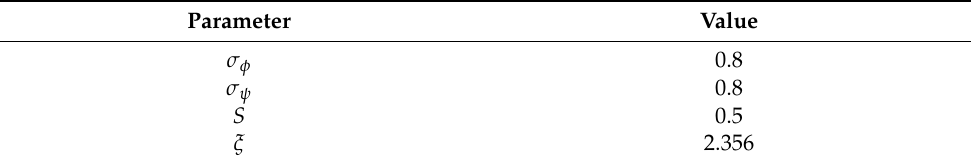
Table 2. Parameter values of mother Morlet wavelet and Gaussian windowing